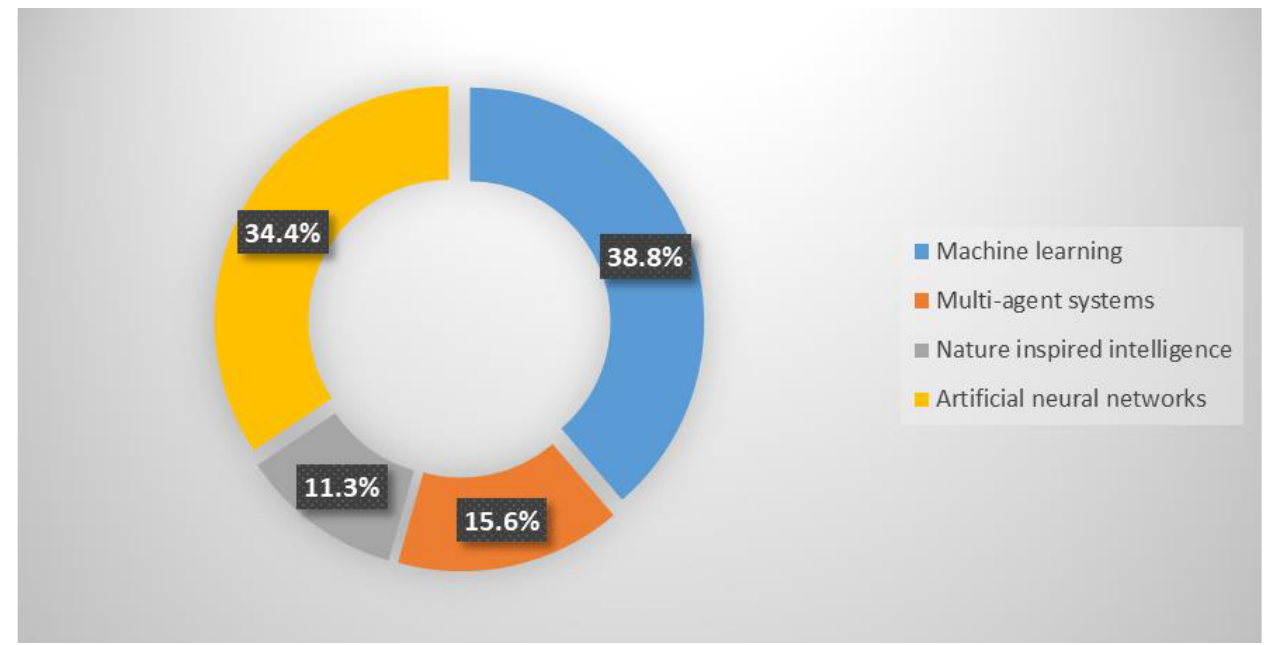
Figure 3. AI techniques used in the reviewed literature.